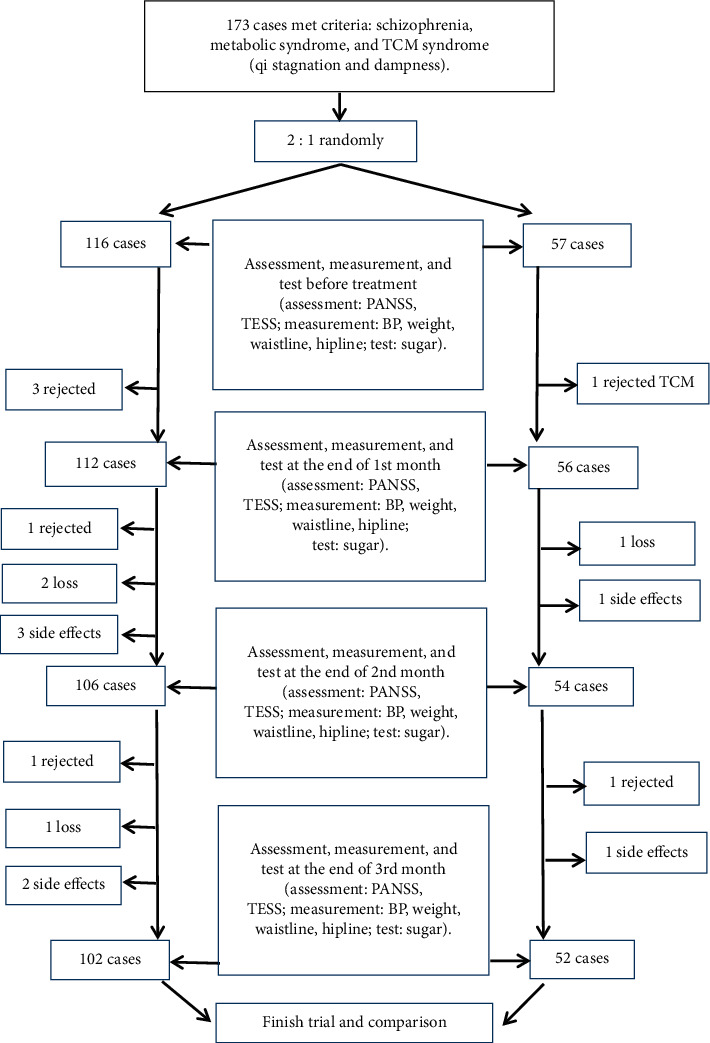
Schedule of trial.